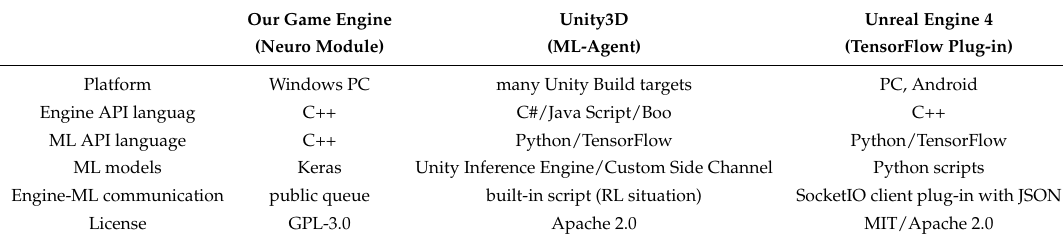
Table 2. Comparisons on DNN (deep neural network)